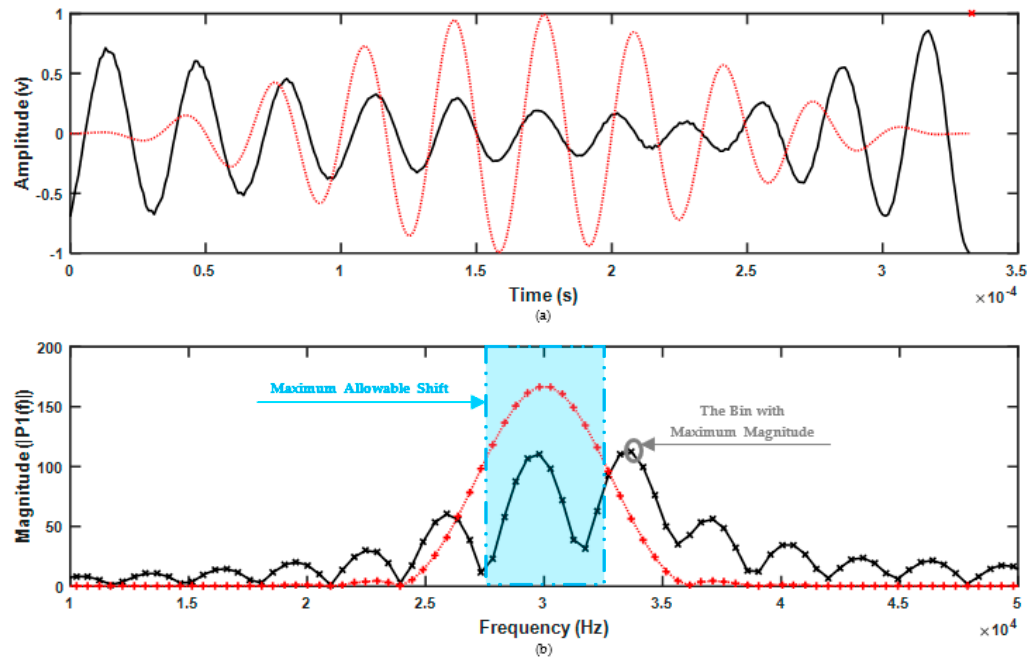
Figure 6. Example of an outlier case detected using Condition Zero (C0), where ( a ) shows the time domain of the iteration window and ( b ) is its respective power spectrum. The red lines (dotted, +) show the references achieved from excitation sequence and the black lines (x, solid) show the results from each iteration.